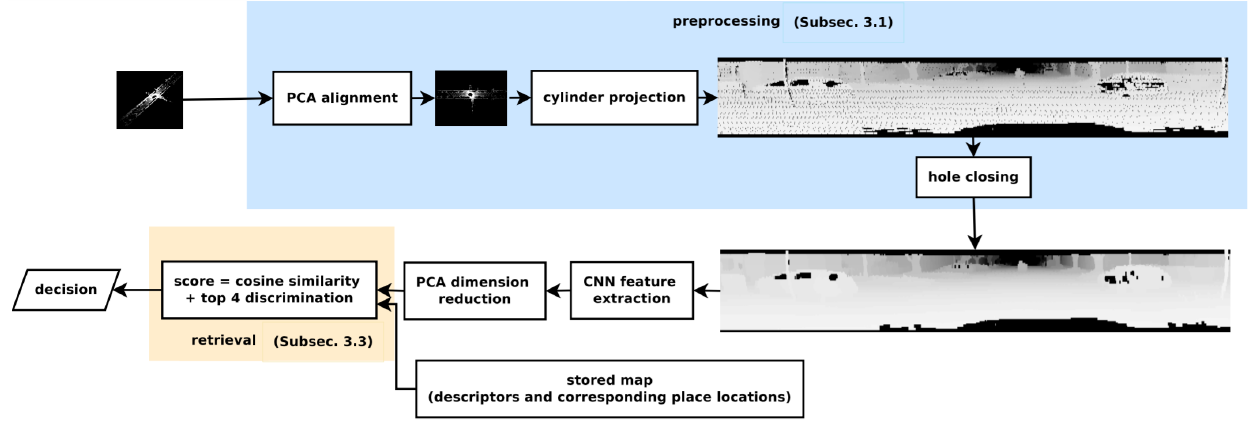
Figure 29. The system overview [82] for point-cloud-based place recognition using CNN feature